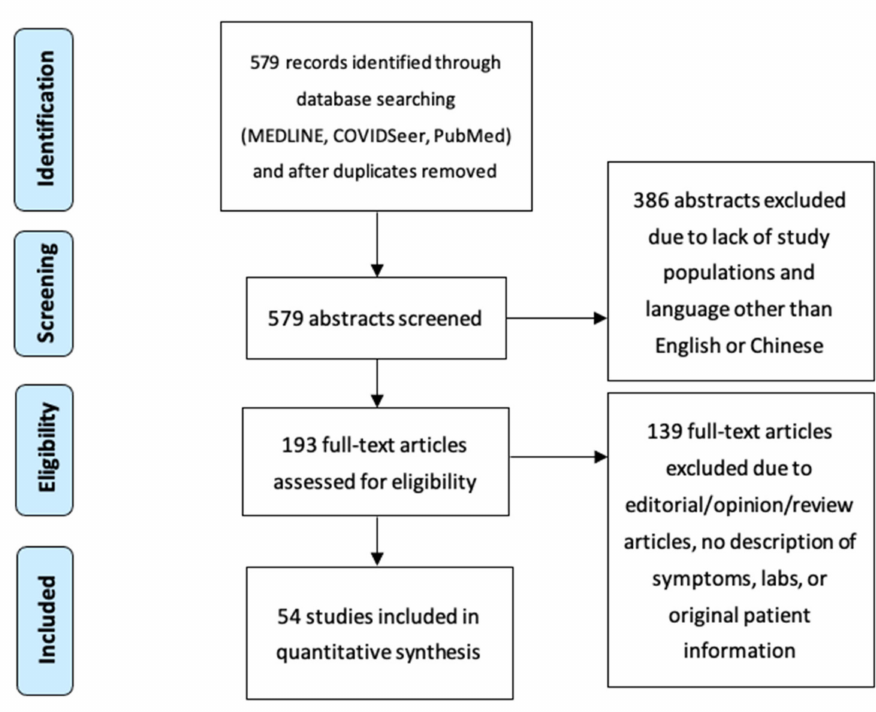
Figure 2. Preferred Reporting Items for Systematic Reviews and Meta-Analyses (PRISMA) flow chart illustrating the inclusion and exclusion of studies for the review [20]. Published under the terms of the Creative Commons Attribution